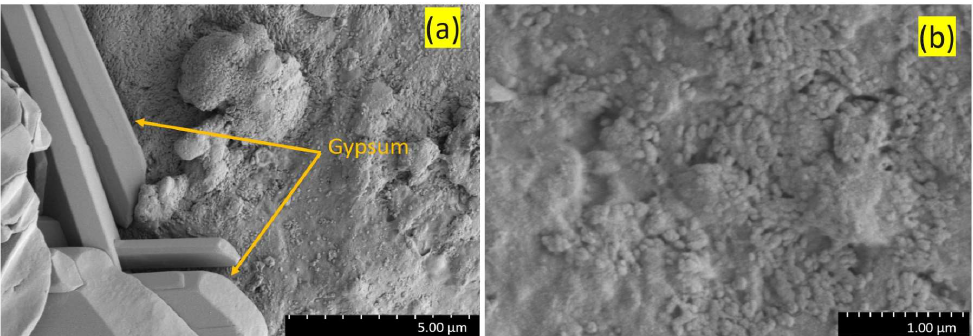
Figure 11. SEM high-magnification images (SE) of the surface of jarosite formation showing gypsum crystals from Stefføya ( a ) and rod and globular morphologies ( b ).